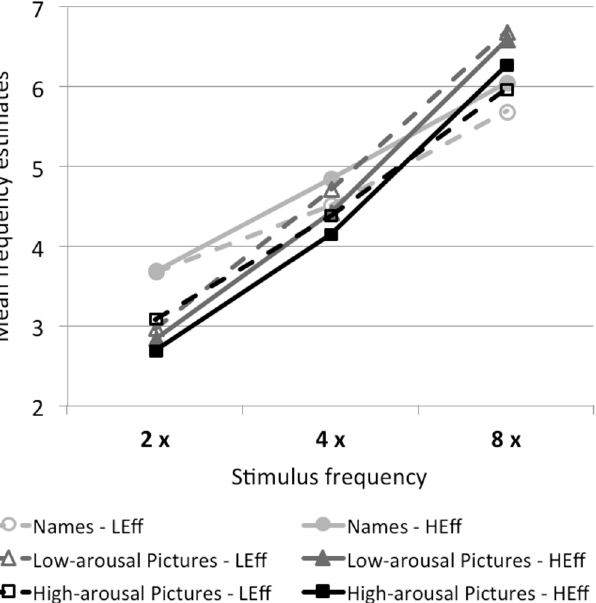
Fig 2. Sensitivity to frequency. Sensitivity to stimulus frequency in the different stimulus-type and physical- effort conditions. Stimuli were presented two (2 x), four (4 x), or eight (8 x) times. Frequency estimates are averaged per participant over the three levels of presentation duration. LEff = low physical effort; HEff = high physical effort. The figure shows a high sensitivity to frequency in each attention condition.